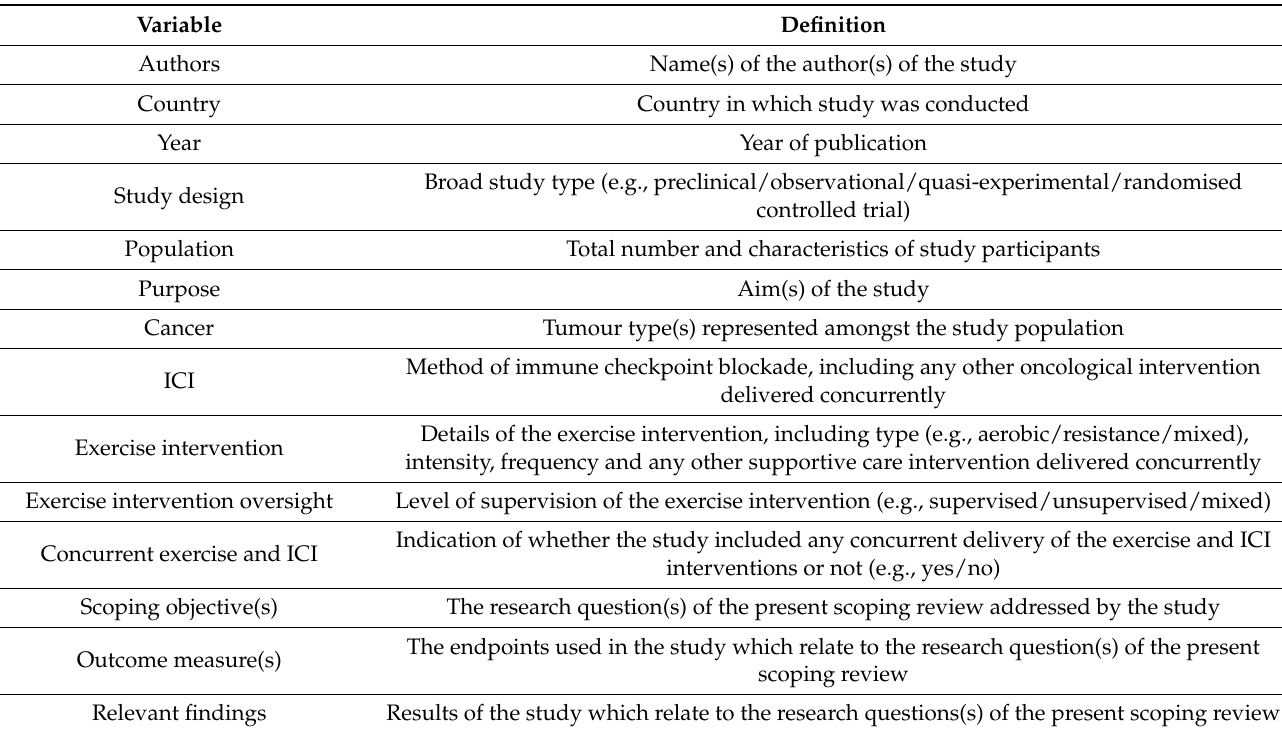
Table 1. Variables for which data were sought from eligible